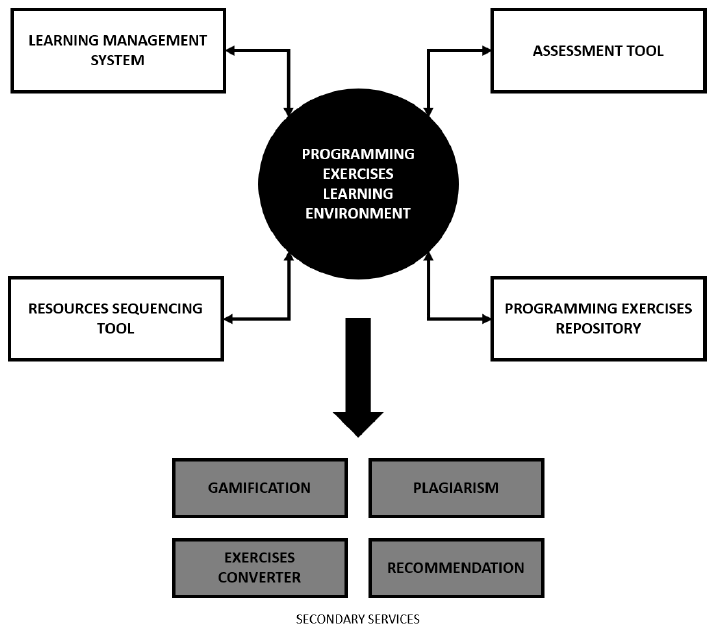
Figure 1. Programming exercises learning environment